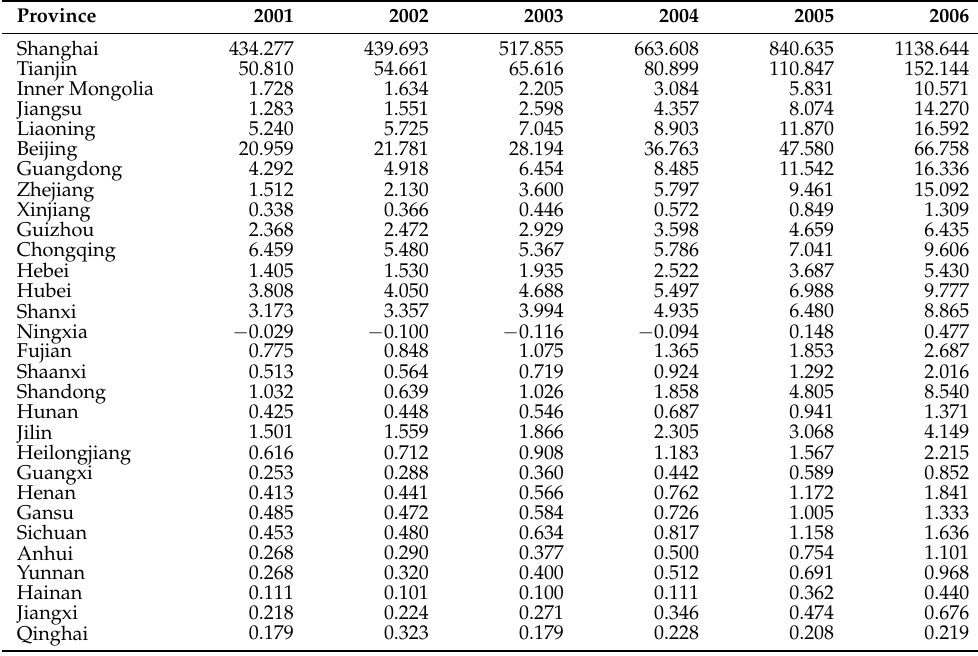
Table A10. The intra-provincial carbon inequality estimation results of original carbon emission data based on a 5-year rolling window for 30 provinces in China from 2001 to